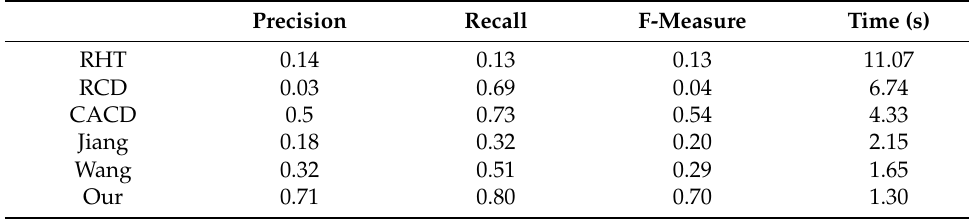
Table 7. Results on the dataset